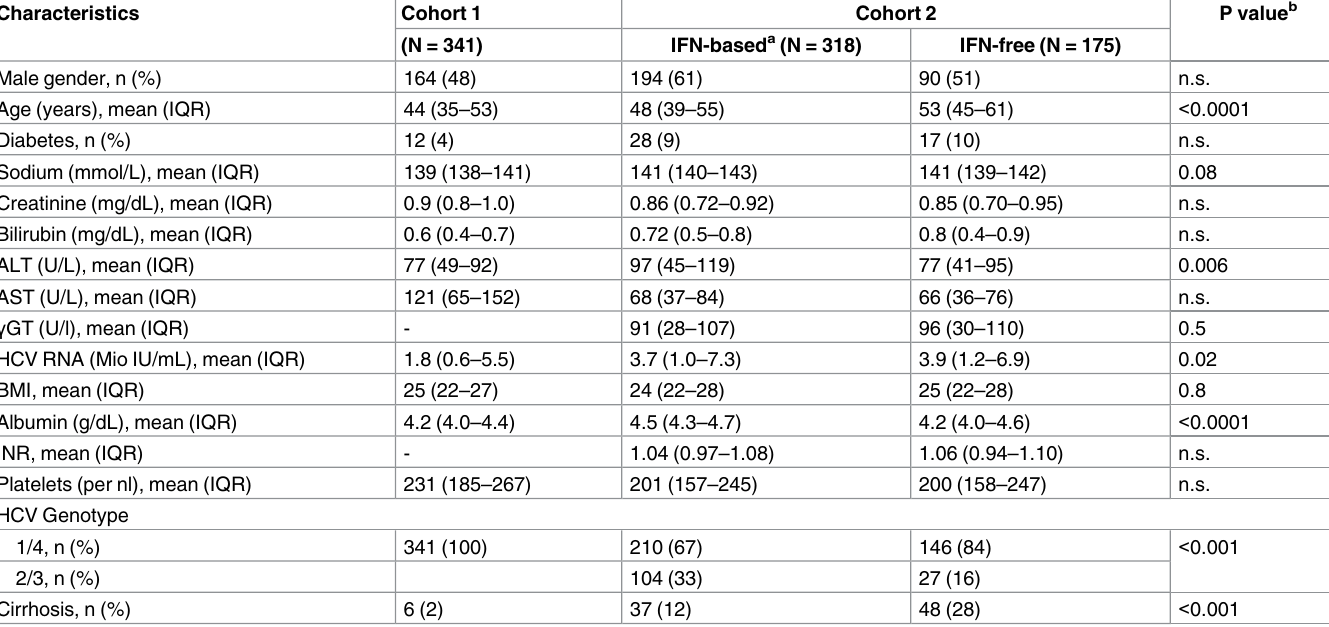
Table 1. Baseline characteristics of included